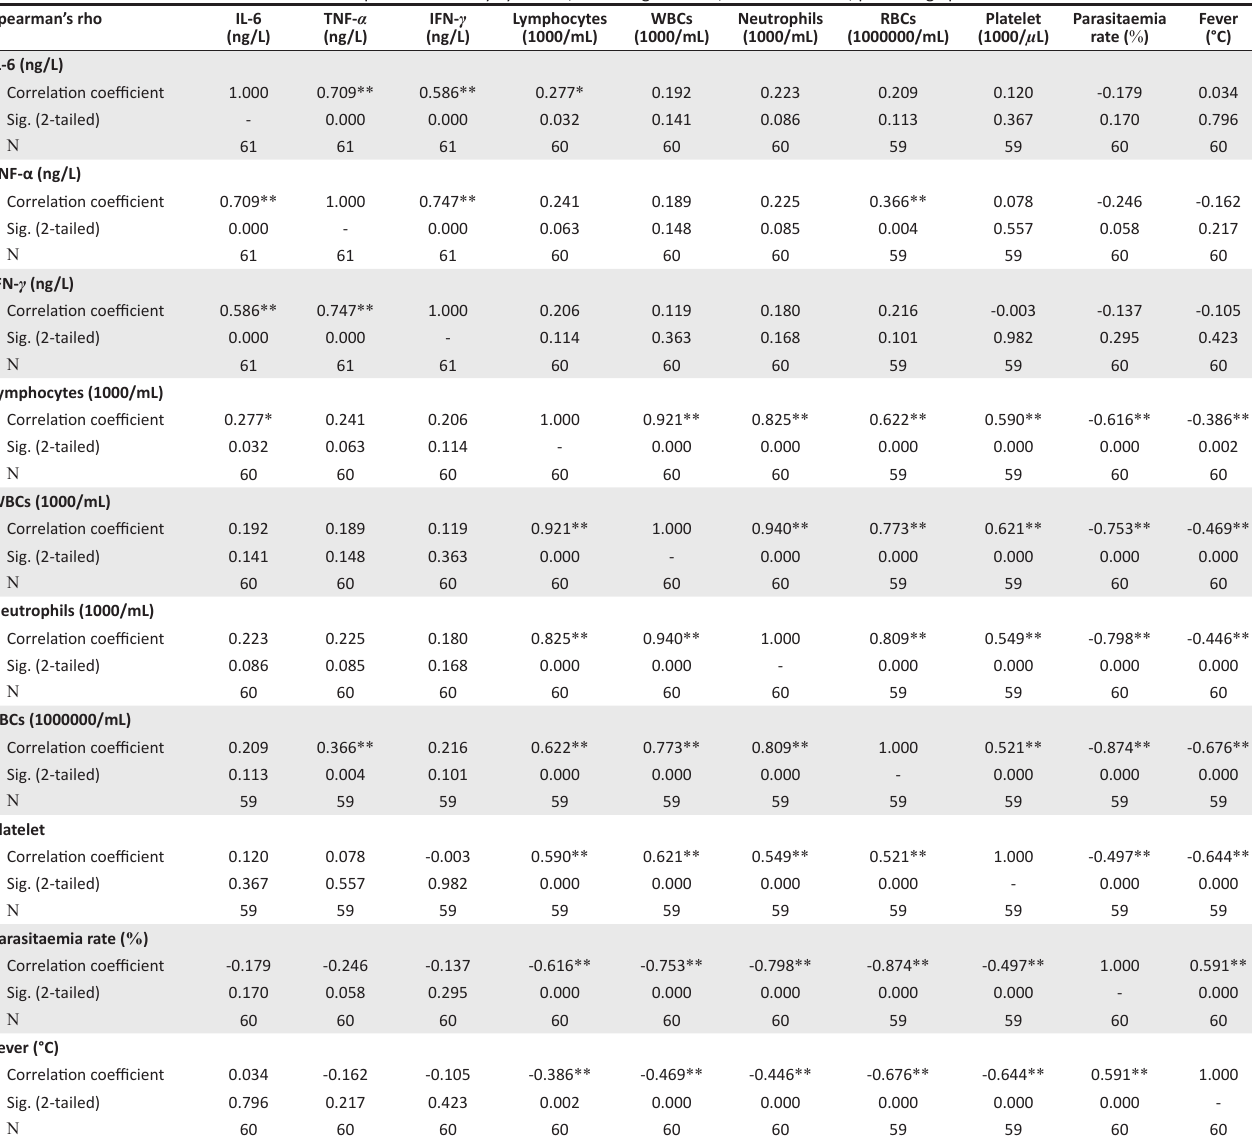
TABLE 2: Correlation between the mean levels of proinflammatory cytokines, immunoglobulin G, cell blood count, percentage parasitaemia and fever. Spearman’s rho